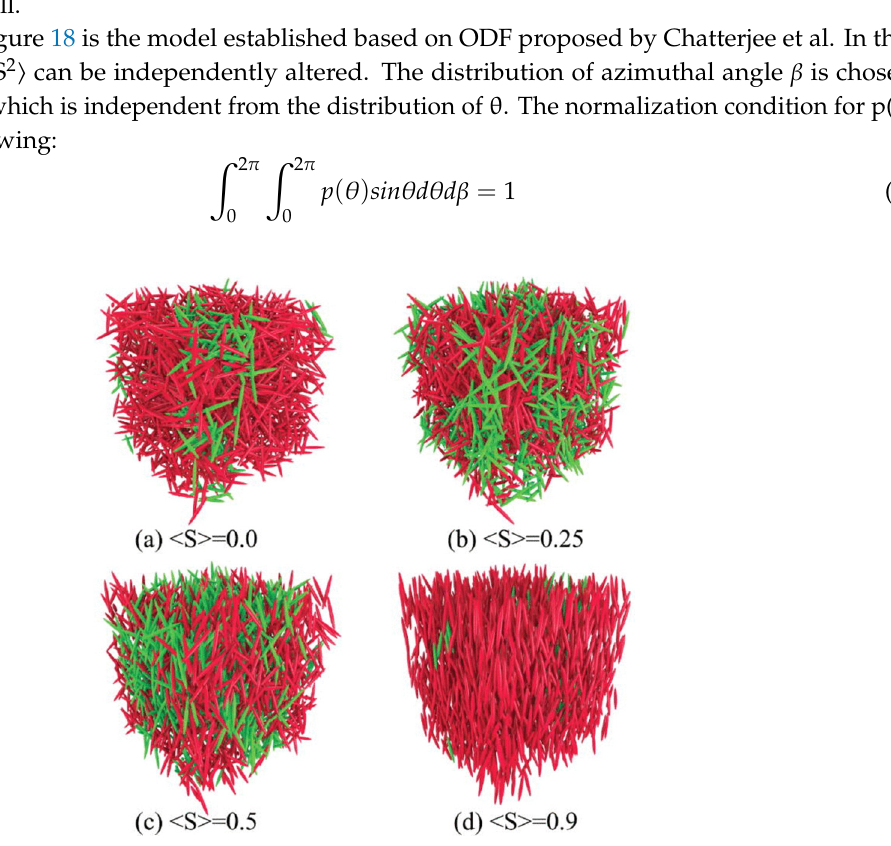
Figure 18. Increased alignment of prolate ellipsoids at various nematic order parameter < S > of ( a ) 0, ( b ) 0.25, ( c ) 0.5 and ( d ) 0.9. The green fillers are percolating clusters, while red fillers are other isolated clusters. The m value is equal to m min (m ≥ m min = 3 (cid:104) S (cid:105) / (1 −(cid:104) S (cid:105) ))